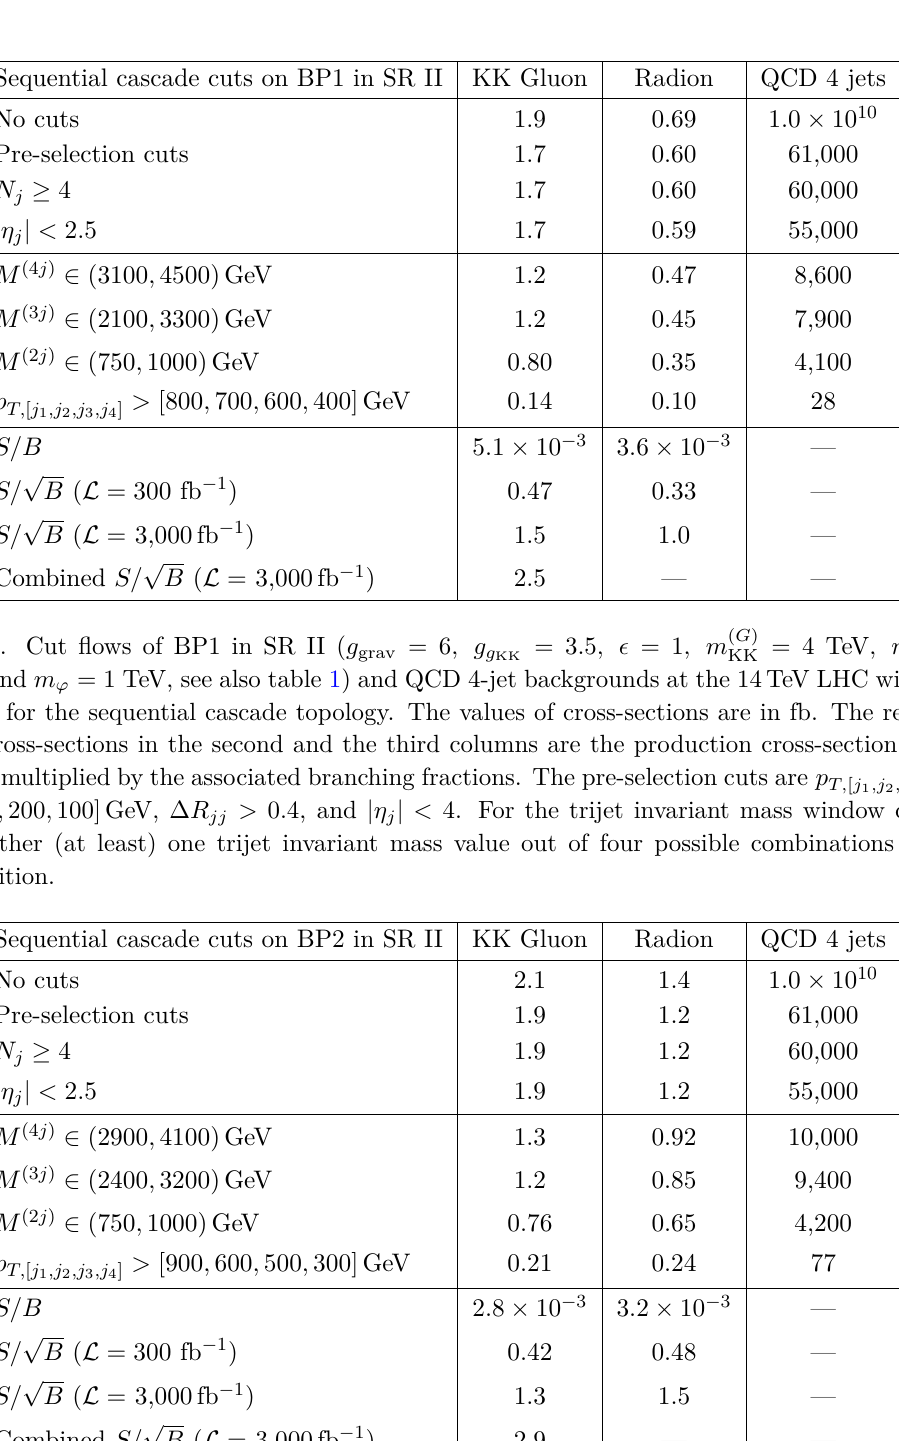
— — = 3 . 75 , (cid:15) = 1 , m ( G ) = 3 . 75 TeV , m ( g ) = KK KK KK